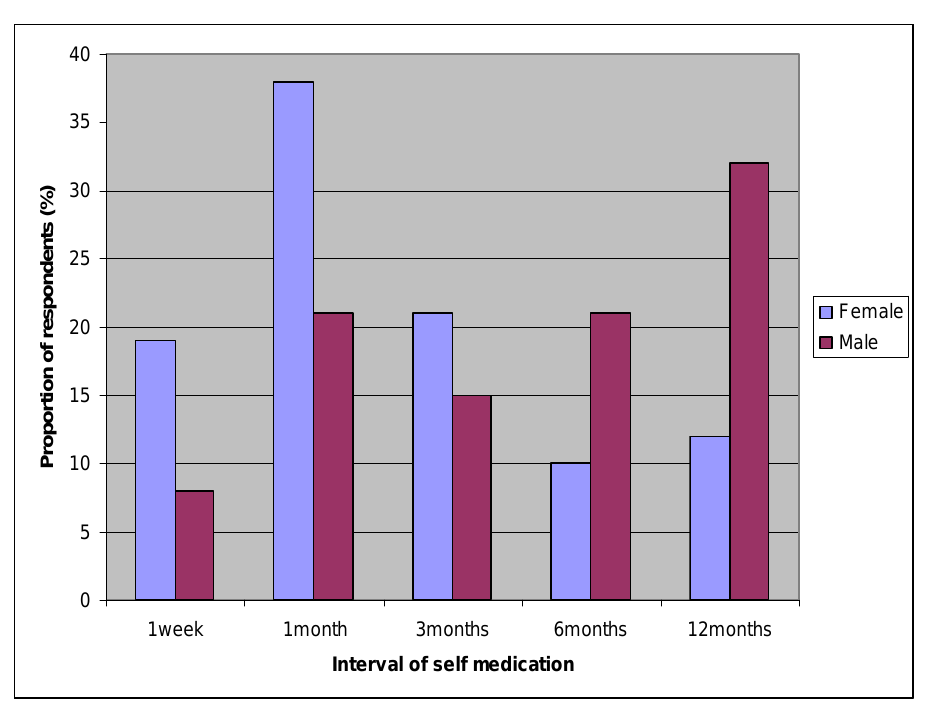
Figure 1. Rate of self medication among male and female